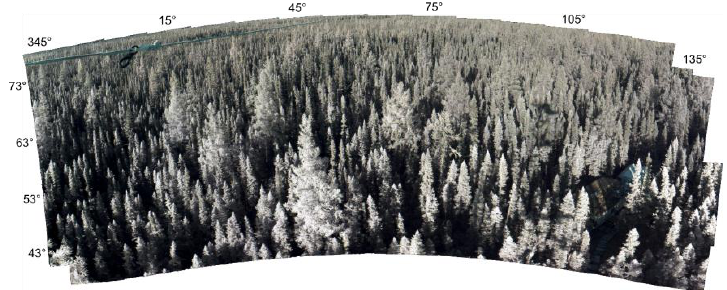
Figure 2. Image composite at SOBS over a ~165° observation cycle. The photographs have been stitched from 57 individual observations (340° ≤ φ v ≤ 145°) using Microsoft ® Research Image Composite Editor.